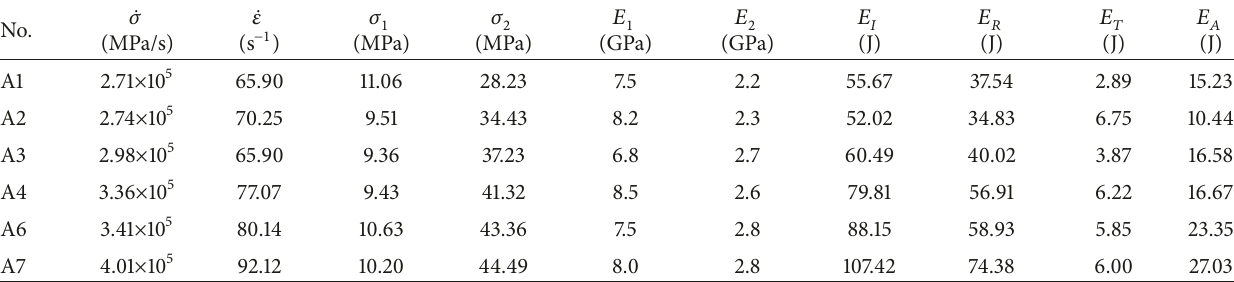
Table 2: Test results of dynamic compressive tests of coal-rock combined body.